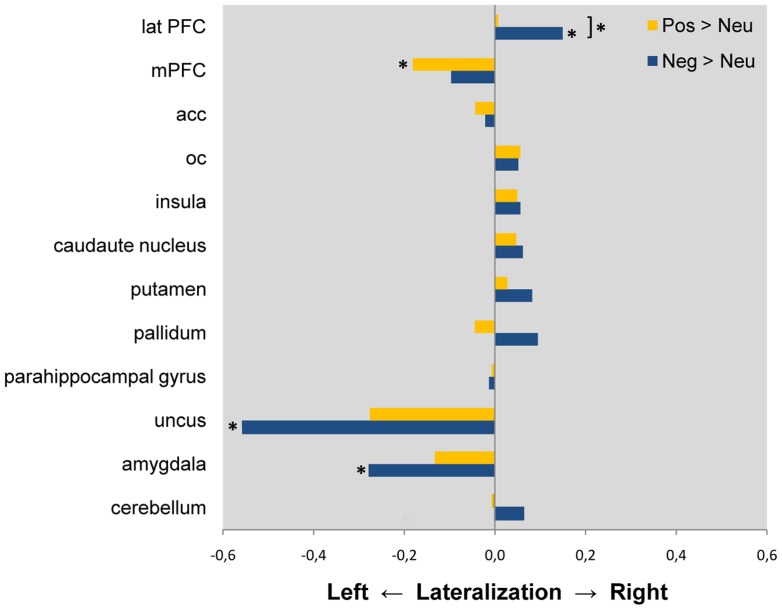
Lateralization during positive and negative picture viewing. ROI analysis.Lateralization of BOLD responses in regions of interest. The bars represent hemispheric differences of contrasts of parameter estimates (red: ‘positive > neutral’; blue: ‘negative > neutral’) extracted from the respective ROI (mean values for the respective ROI, averaged across the 36 participants). Bars extending to the left indicate lateralization towards the left (left > right), and bars extending to the right indicate lateralization towards the right (right > left). *p<0.05; (*) p<0.1 on tests of laterality within valence condition (positive or negative), or between positive and negative valence conditions if marked by brackets. Lat PFC, dorsolateral prefrontal cortex; mPFC, medial prefrontal cortex; acc, anterior cingulate cortex; oc, occipital cortex.